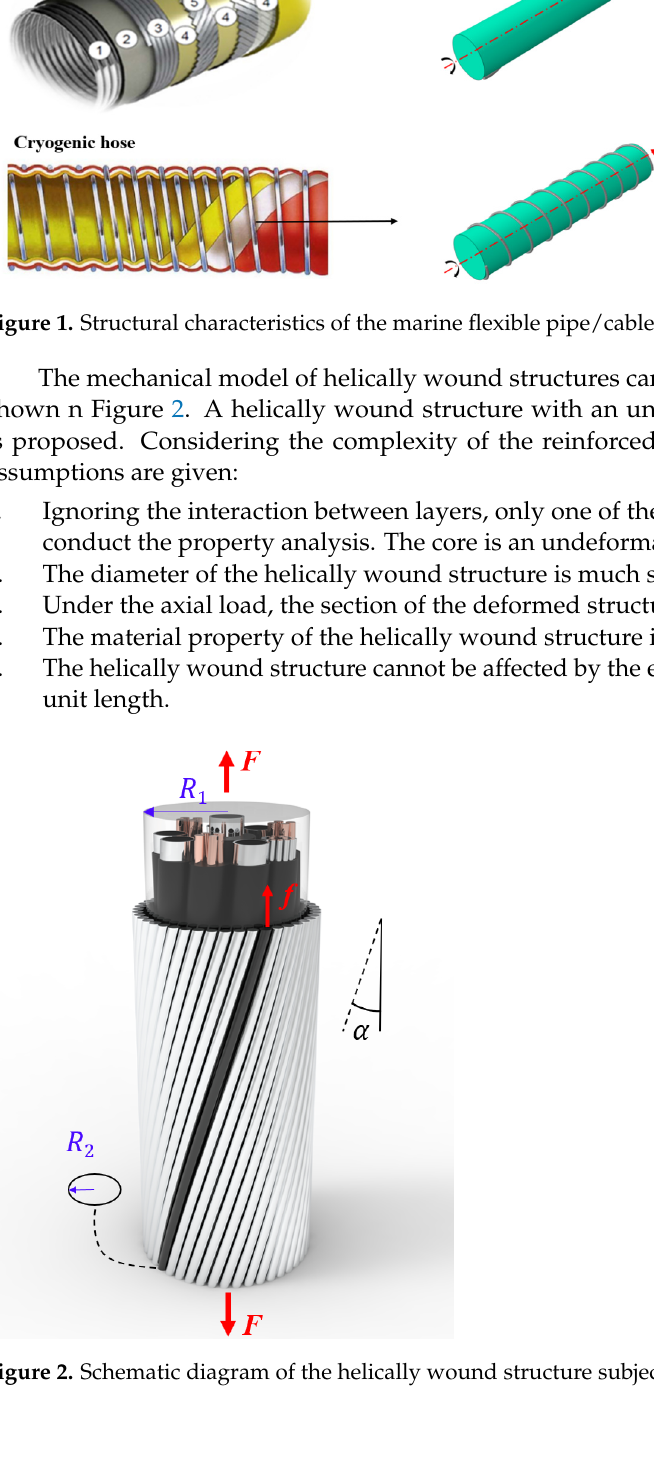
Figure 1. Structural characteristics of the marine flexible pipe/cables armoring layer.